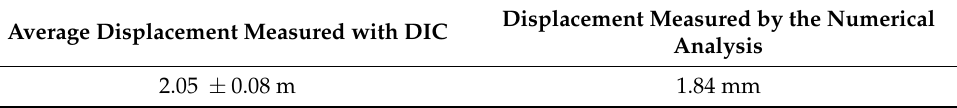
Table 5. Comparison between curing displacements of the specimens: experimental vs. numerical.